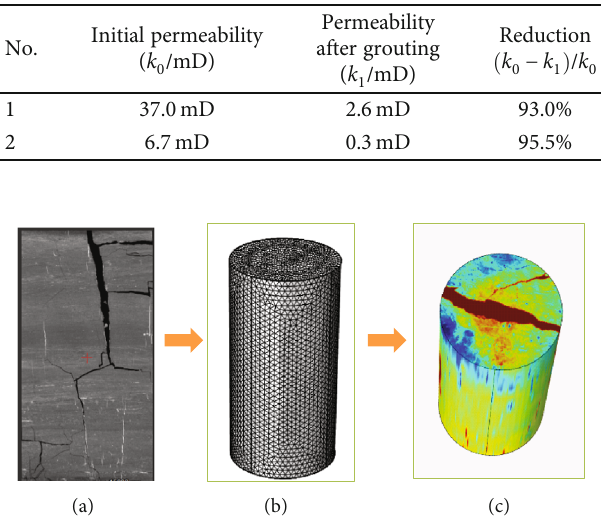
Figure 10: Numerical calculation model of grouting in fractured coal samples. (a) CT scanning fracture. (b) Model meshing. (c) Numeralization fracture